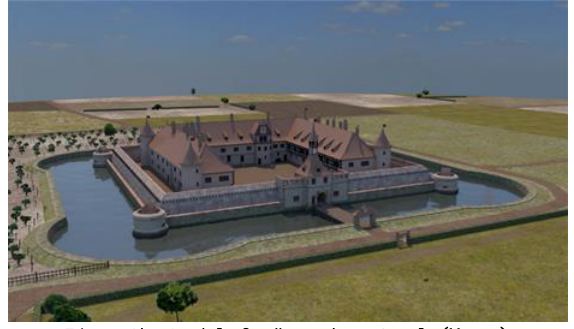
Figure 9b: Model of Württemberg Castle ( Maya